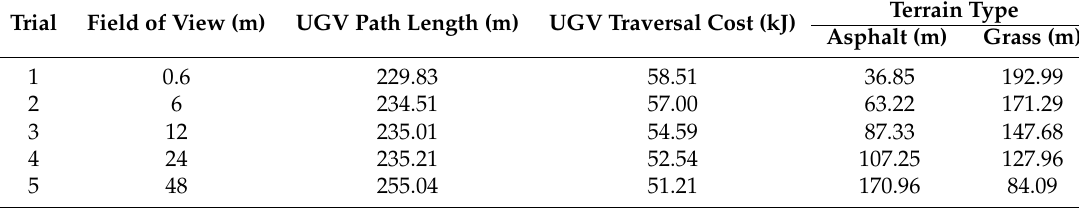
Table 1. The UGV planned path energy cost vs. aerial imagery field of view. Note that while total path length increases, energy cost decreases because of the reduced distance driven on grass. The paths are shown in Figure